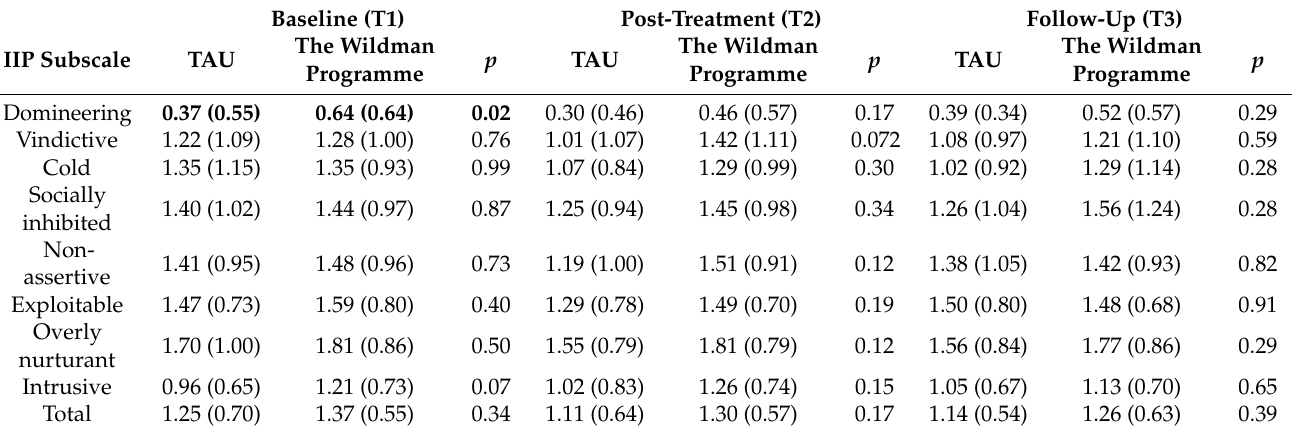
Table 2. Differences between mean-scores at baseline, post-treatment, and follow-up.